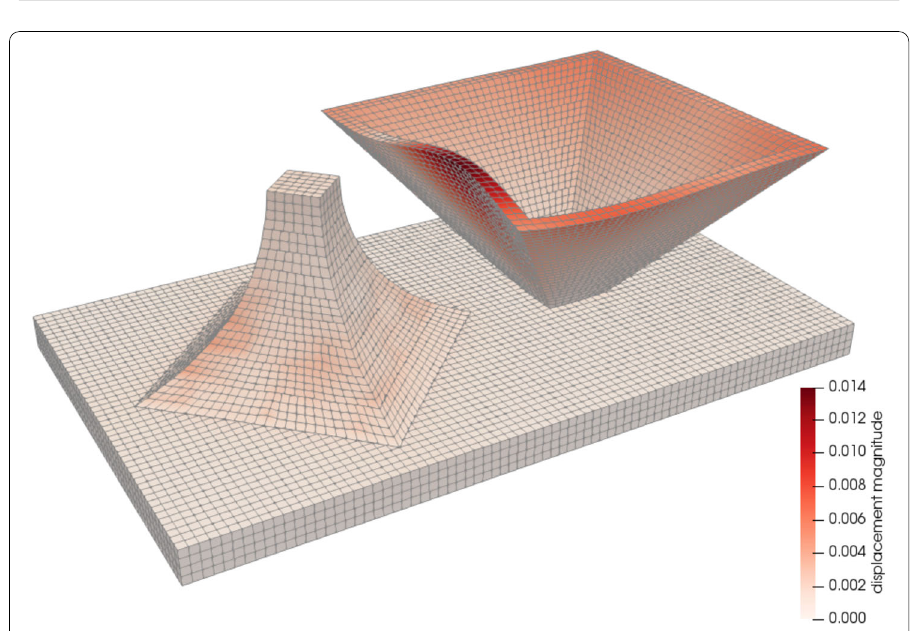
Fig. 25 Two pyramids example: displacement magnitude after final cooldown displayed on warped geometry. The distortion is scaled up by a factor of 5